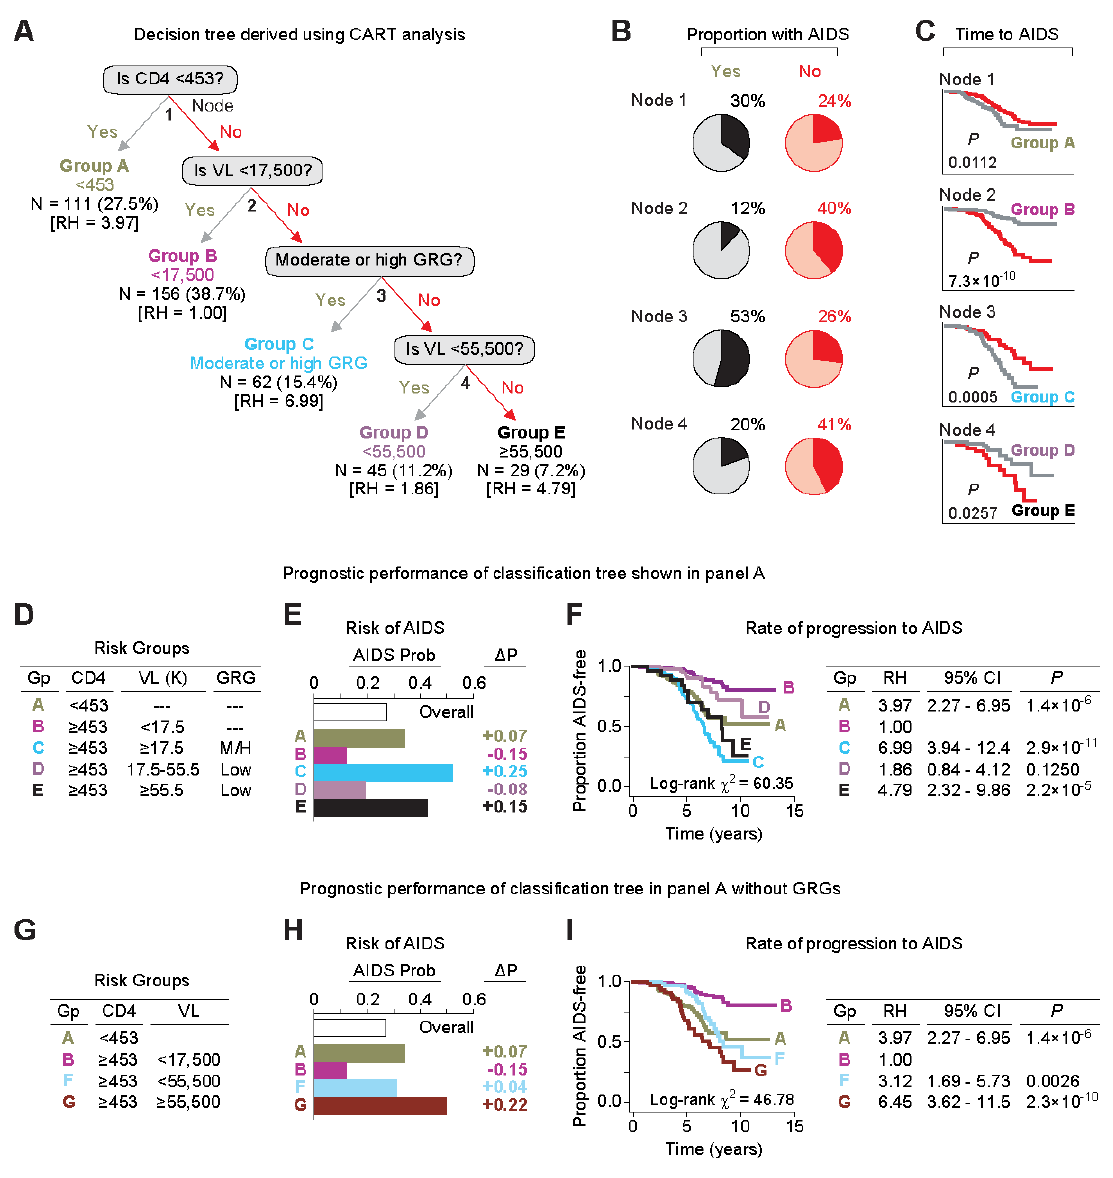
Figure 2. Classification trees and their application in the seroconverting component of the WHMC HIV + cohort. ( A ) A binary decision tree derived by CART analysis for the risk of developing AIDS (1987 criteria) based on baseline CD4 + T cell counts, viral load (VL) and GRG status in the seroconverting component of the WHMC HIV + cohort. The analysis identified five exclusive groups designated as Groups A to E. The tree shows that the proximal split was based on the CD4 cell count, and the CART analysis generated the cut-off to be 453 cells/mm 3 . The next split was based on a viral load of 17,500 copies/ml. The third split was based on GRG status, followed by another split at a viral load of 55,500 copies/ml. The five groups generated are color-coded and the number of subjects in each of these groups is shown along with their proportion in the study group. The values in brackets ([ ]) indicate the relative hazard estimates corresponding to each of these groups as shown in Figure 2F. ( B ) Pie charts depicting the proportion of subjects in each of the splits who did or did not develop AIDS (1987 criteria). Within each pie-chart, the dark pie-slice represents the proportion of subjects who developed AIDS. Yes and no refers to whether a subject does or does not categorize, respectively, to the indicated node. ( C ) KM plots for the rate of progression to AIDS from time of seroconversion based on the split at each corresponding node in the decision tree shown in panel A. The significance values shown below each KM plot were estimated using the logrank test. ( D–F ) Association between the five risk groups (panel D) generated by CART and the risk (panel E) and rate of developing AIDS (panel F). Panel D defines the risk groups based on the baseline CD4 (cells/mm 3 ), steady state viral load (k, 6 1,000 copies/ml), and GRG status (M/H, moderate or high GRG; Low, low GRG). Gp, group. Panel E shows the probability (Prob) of developing AIDS within each risk group generated by CART analysis. ‘‘Overall’’ refers to the probability of developing AIDS in the seroconverting component of the cohort without accounting for the laboratory or genetic markers. D P, change in probability from the overall probability. Panel F shows the KM plots for rate of progression to AIDS for the five groups of subjects identified by CART. The table to the right shows the relative hazards (RH) corresponding to these five groups estimated by using Cox proportional hazards models. In these analyses, the reference category (RH=1) is group B, which denotes subjects that have a CD4 of $ 453 cells/mm 3 and a viral load of , 17,500 copies/ml. The results show that relative to this reference category, groups A, C and E are associated with a significantly increased risk of progressing rapidly to AIDS. ( G–I ) Similar analyses to those shown in panels D to F but using risk groups in which the GRGs are not included as prognosticators. In these analyses, the risk groups A and B shown in panel A and panel D were used along with two new groups designated as group F and group G. The latter two groups were derived from the Groups C to E shown in panel D by not accounting for the GRG status and dichotomizing the cohort further based on a viral load cut-off of 55,500 copies/ml. Reference category (RH=1) is group B. In panels E and H, prob refers to probability. doi:10.1371/journal.pone.0003165.g002 PLoS ONE |